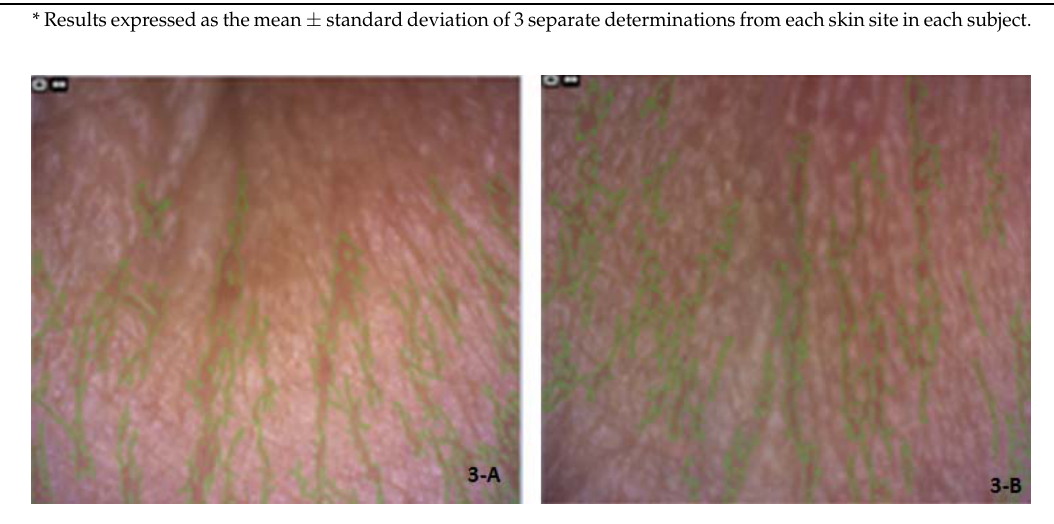
Figure 3. Graphic of typical results for the determination of expression lines, with demarcation in green lines. ( 3 ‐ A ): Wrinkles in the outer corner of the right eye on days 0 and ( 3 ‐ B ): Wrinkles in the outer corner of the right eye on day 45, both in volunteer 17.